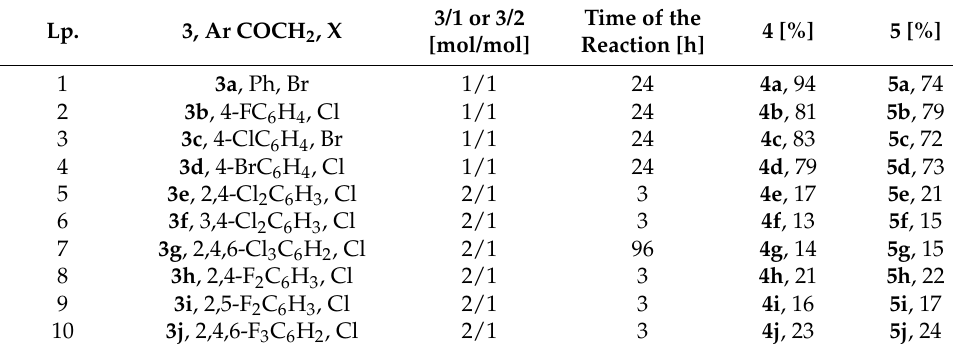
Table 1. N -phenacyldibromobenzimidazoles 4 – 5 .